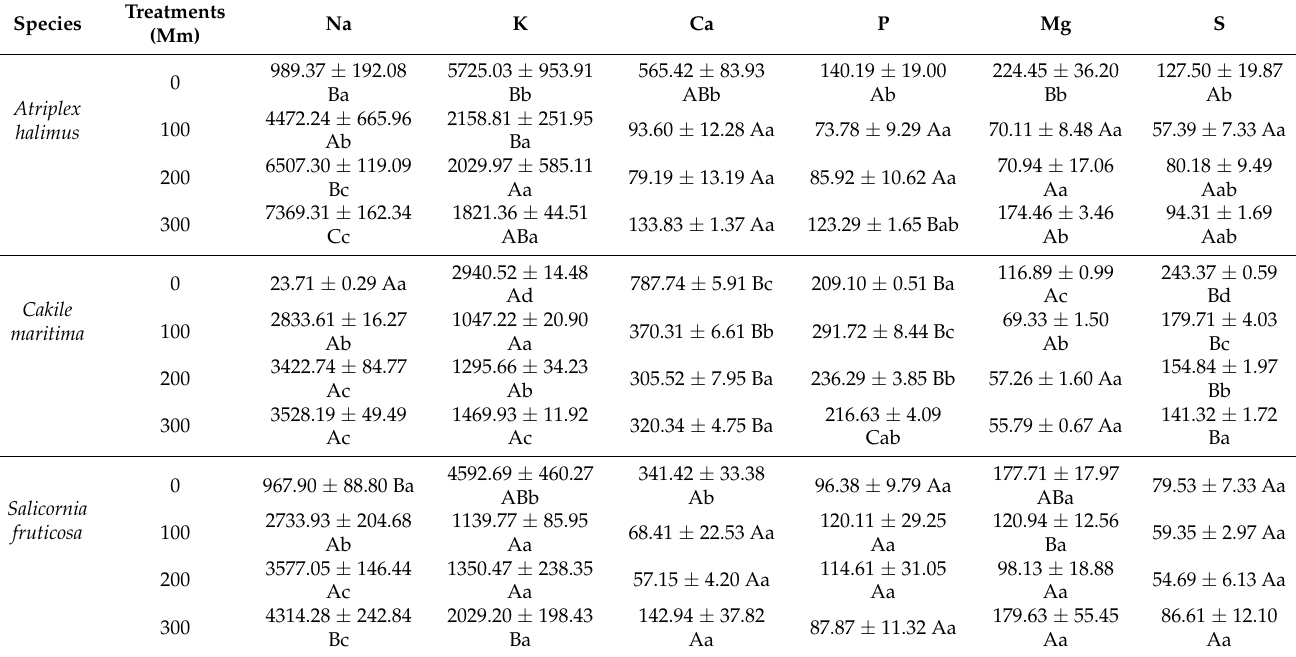
Table 1. Macronutrient content in the leaves and stems of Atriplex halimus , Cakile Maritima , and Salicornia fruticosa grown with different salinity doses (0, 100, 200, and 300 mM NaCl) for two weeks. Cation concentrations are expressed as mg/100 g − 1 DW (mean ± SE, n = 5). Values followed by different letters are significantly different at p -value < 0.05; upper-case letters indicate the differences among the salinity treatments for the same species, lower-case letters indicate the differences among the species for the same treatment. The Tukey HSD test was used for the comparison of means.